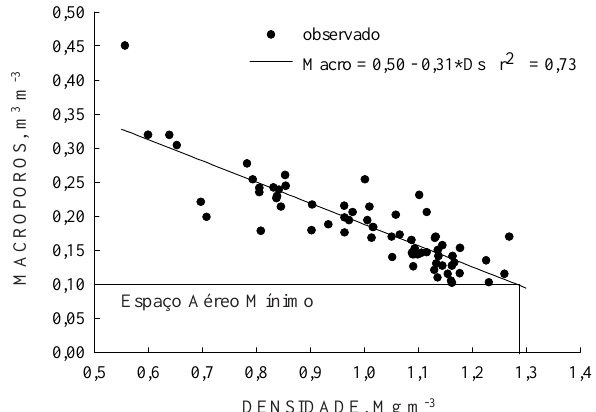
Figura 2. Relação entre macroporosidade e densi- dade do solo nos sistemas de preparo reduzi- do, preparo convencional e na mata